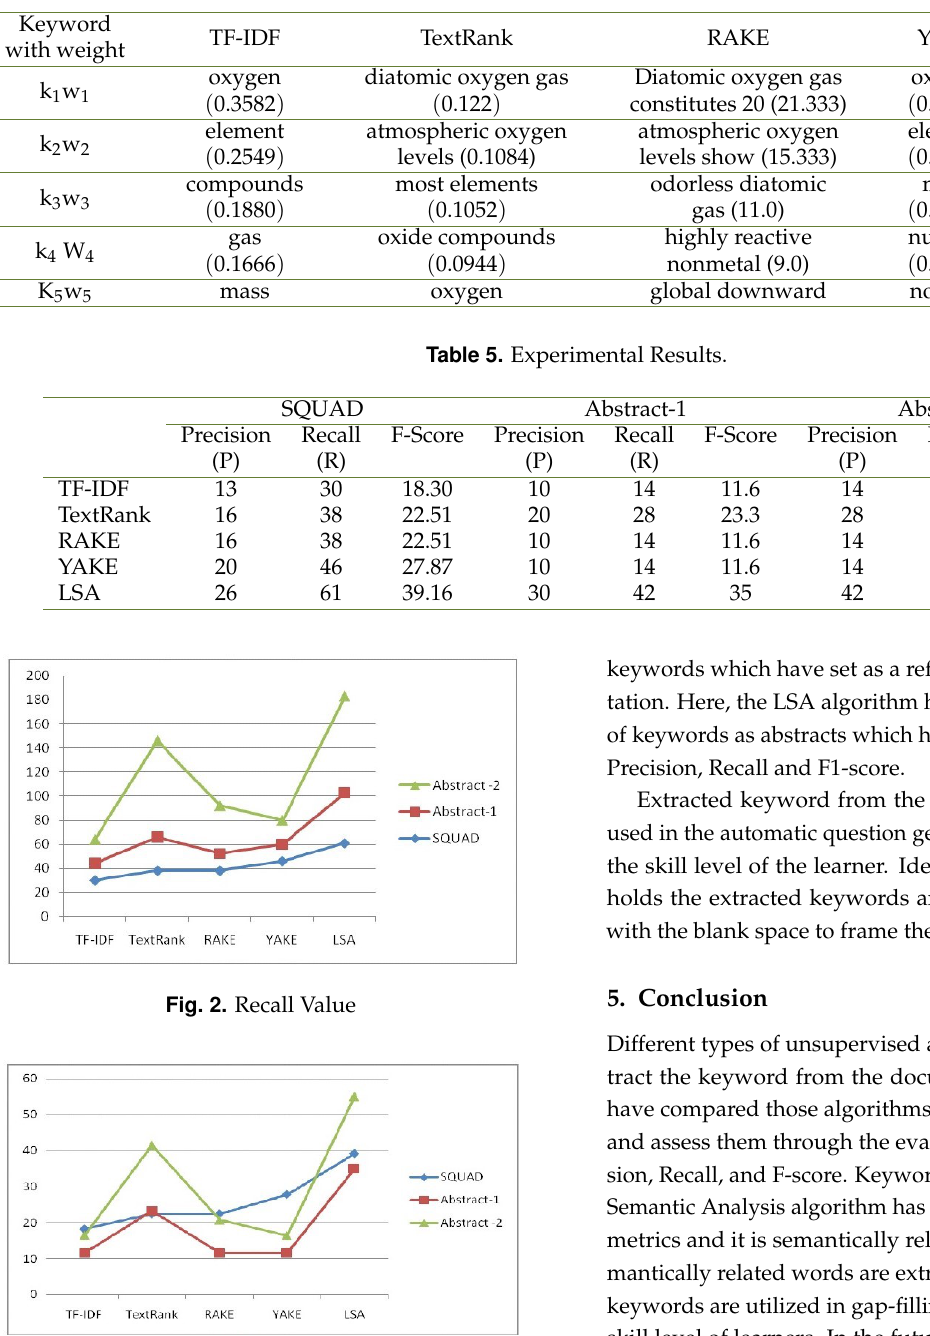
Table 4. Keywords with weight.